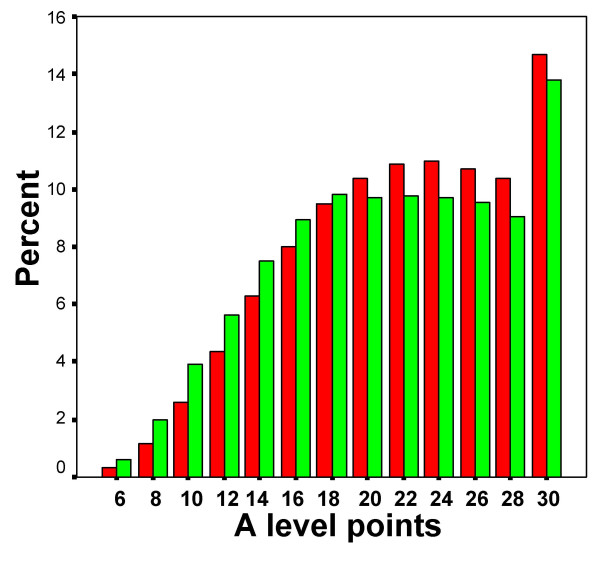
The distribution in all UCAS applicants of A level points gained by W students (red bars) and NW students (green bars).